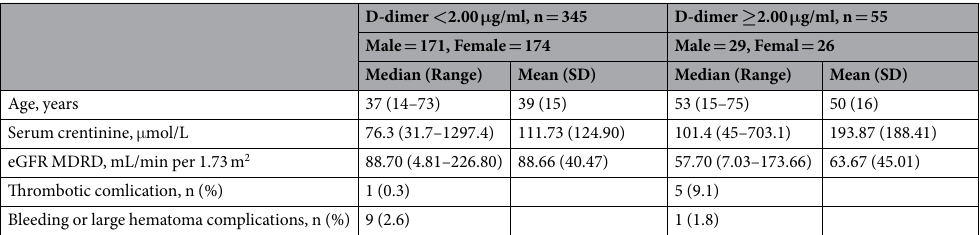
Table 2. Demographic Data of Patients With D-dimer < 2.00 μ g/ml and ≥ 2.00 μ